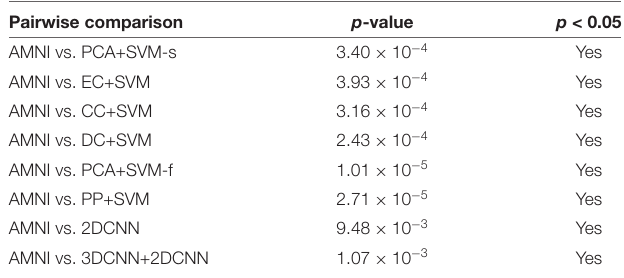
TABLE 4 | Results of statistical significance analysis between the proposed AMNI and eight competing methods. Pairwise